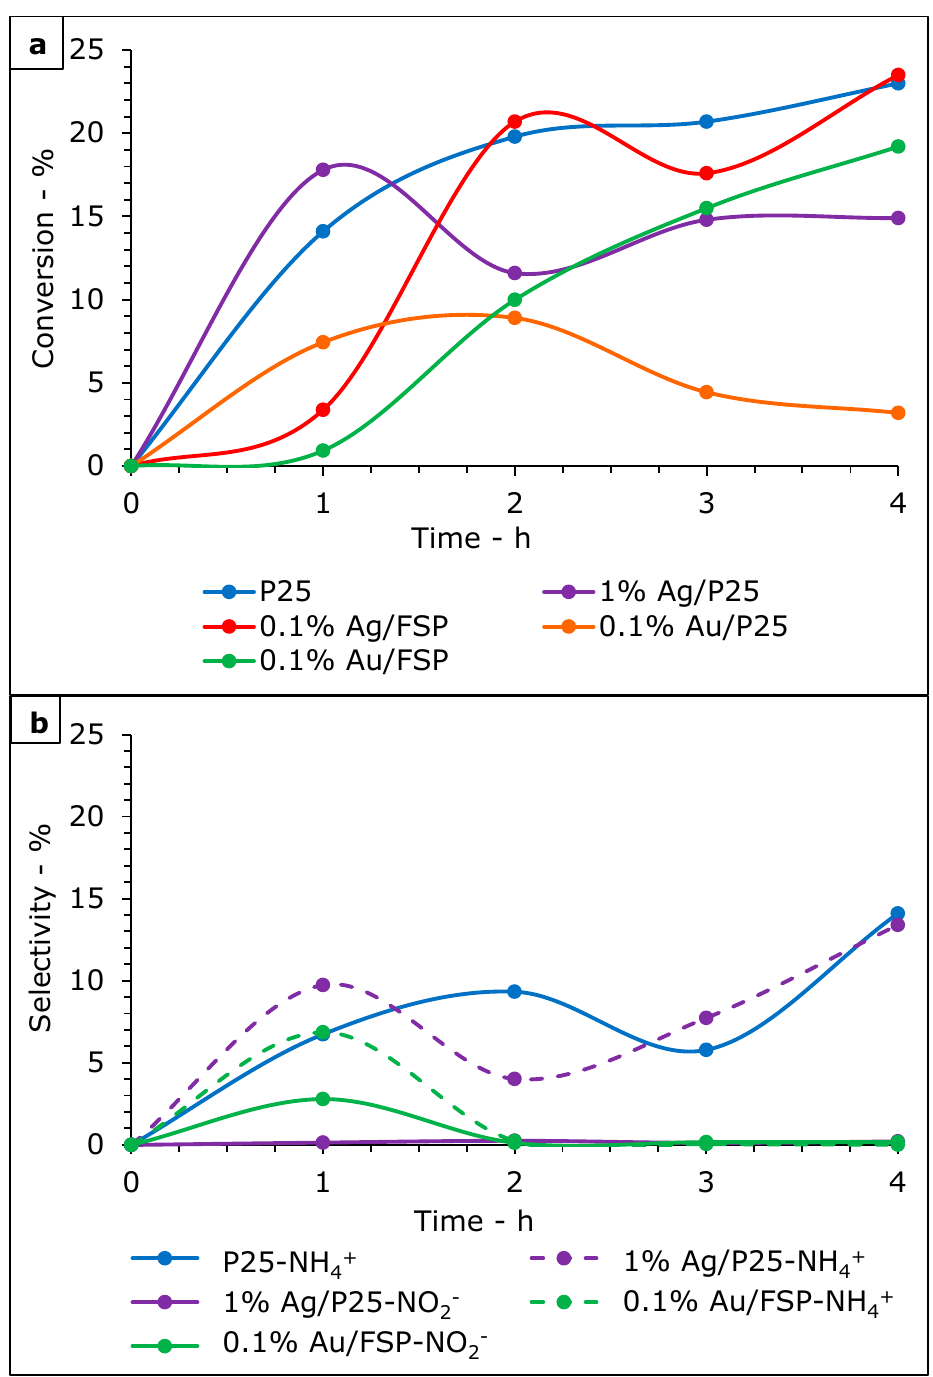
Figure 7. ( a ) Conversion of NO 3 − under LED lamp with several photocatalysts, substrate/cat ratio 34 mmol NO3 − /g cat , NaNO 3 (1.7 mM), pH 5, rt and 1000 mL of solution; ( b ) Selectivity of the photocatalyst towards NH 4+ and NO 2 − . The amount is negligible if not reported.